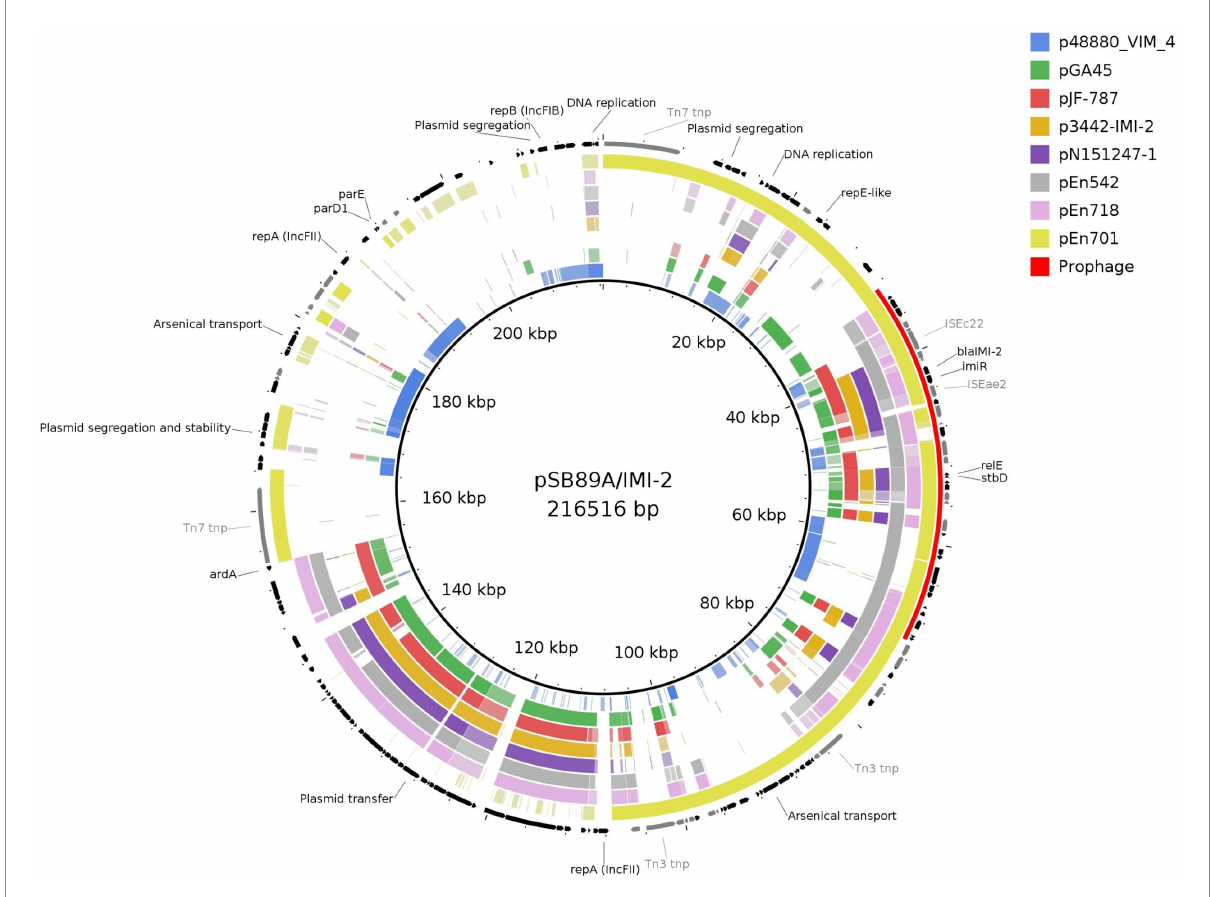
FIGURE 3 Comparison of pSBA89A/IMI-2 to three bla IMI-2 carrying plasmids from human clinical samples sequenced in this study, and to previously published plasmids of which three contains bla IMI-2 (KX868552, CP033468, and KY680213), one containing bla IMI-3 (KT780723), and one negative for bla IMI - genes (CP059418). Genes are shown in black and IS elements in gray. Figure created with BRIG.